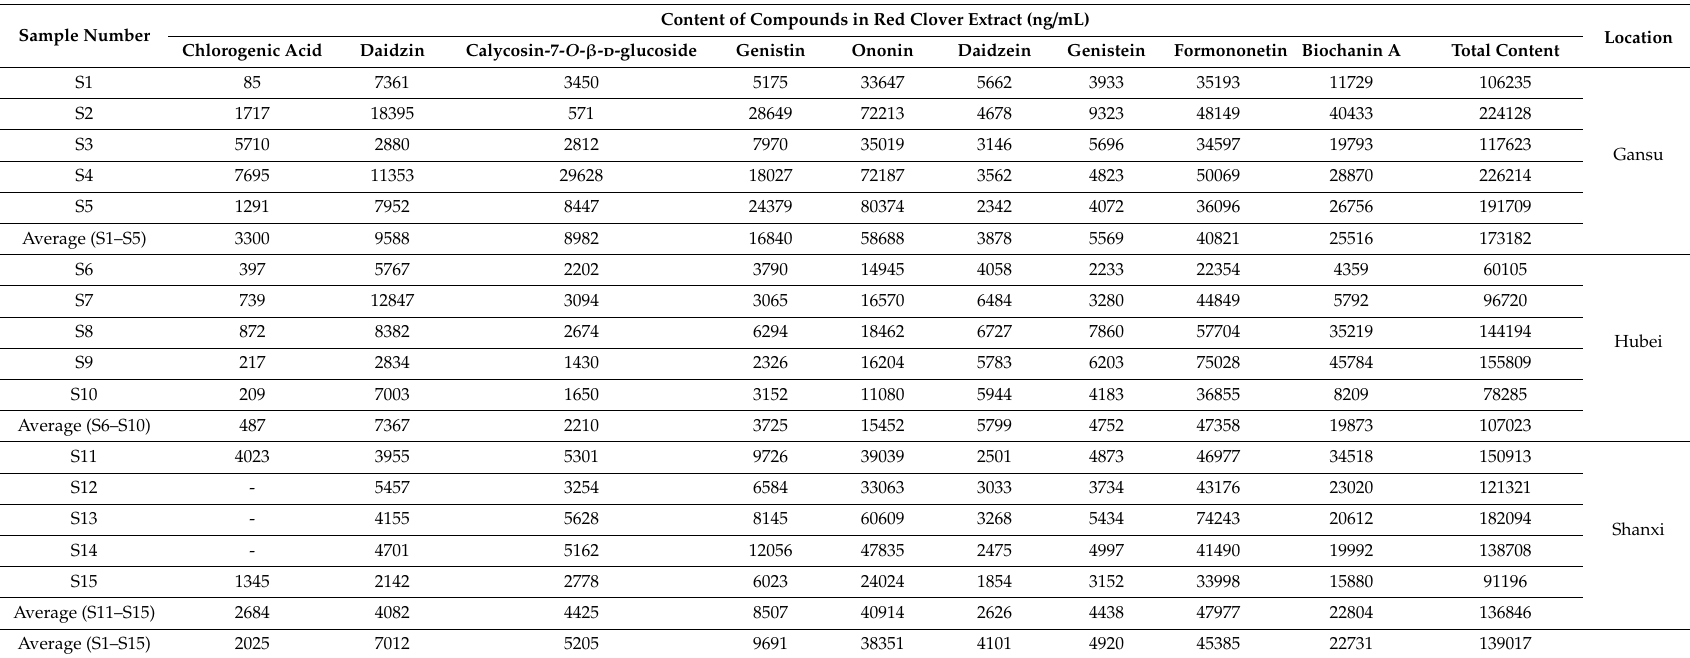
Table 2. The contents of the 9 quality control markers in 15 batches of red